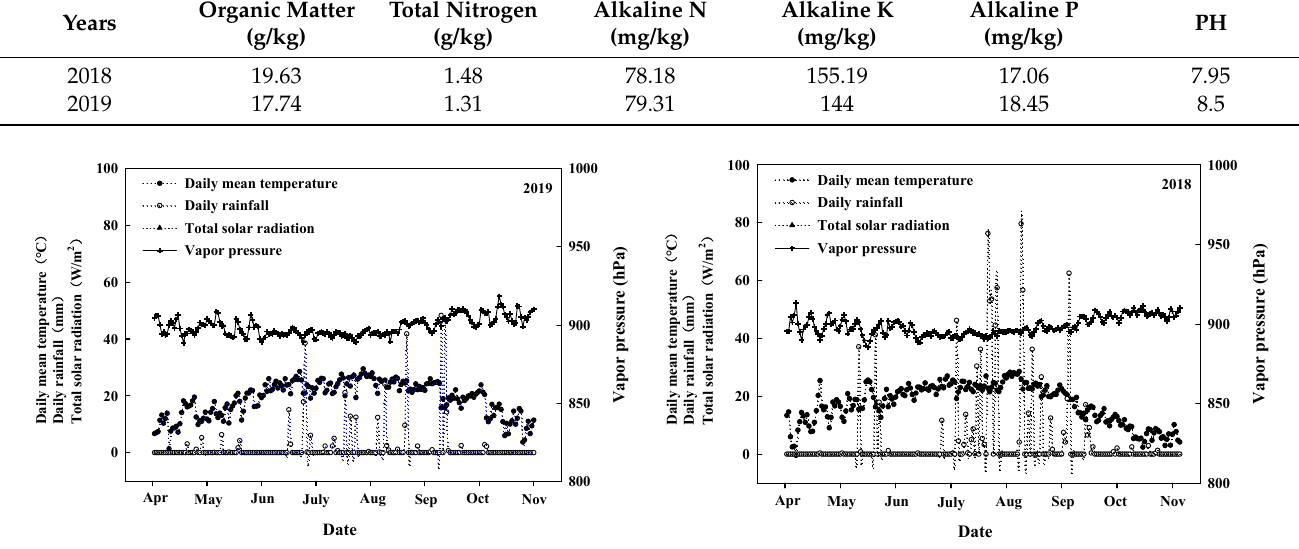
Figure 1. Main meteorological factors during the growth period in the experimental area.